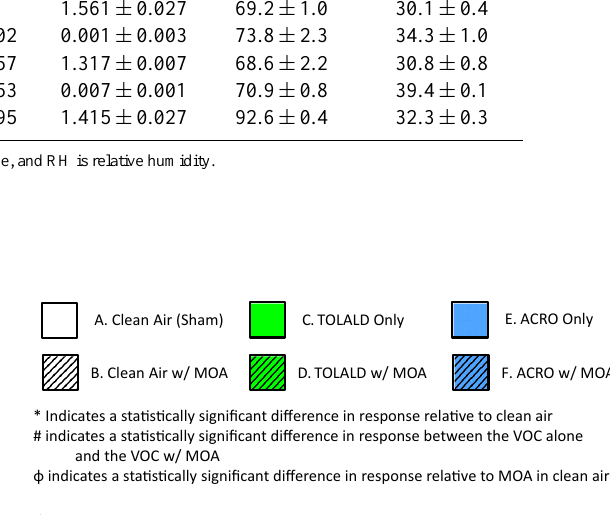
Table 1. Exposure Conditions. All measurements represent the mean value ± 95% confidence interval. Experimental Condition a Avg. VOC Conc. PM Conc. RH Chamber c RH Exposure d (ppmV) (mgm − 3 ) (%) (%) ND b